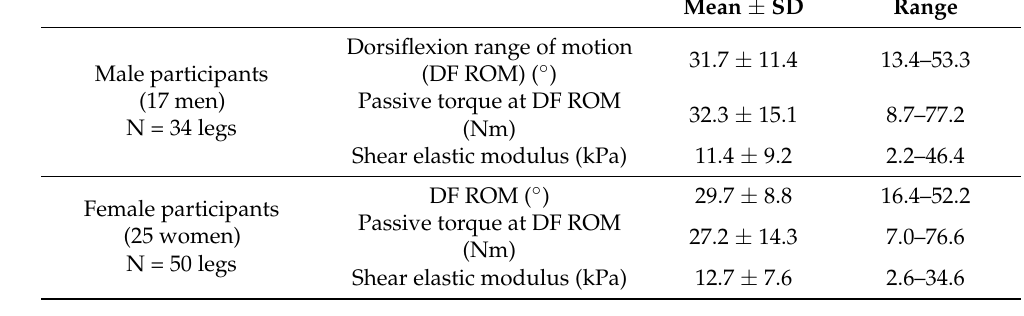
Table 1. The outcome variables in both elderly men and women.